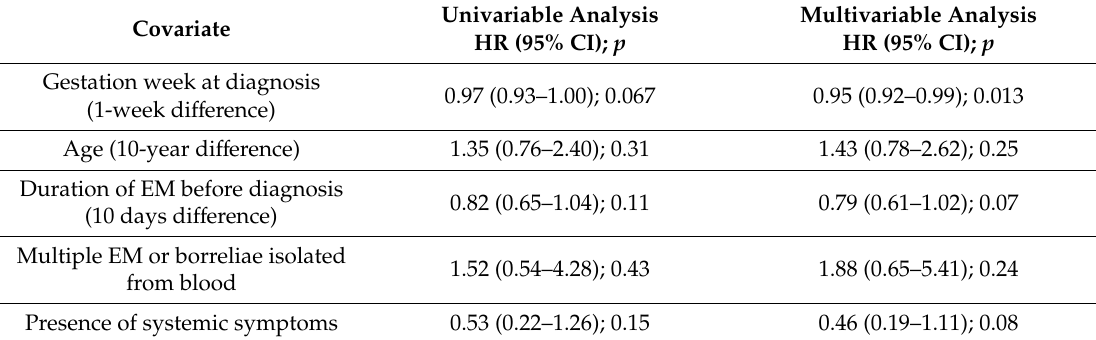
Table 3. Factors associated with unfavorable outcome of